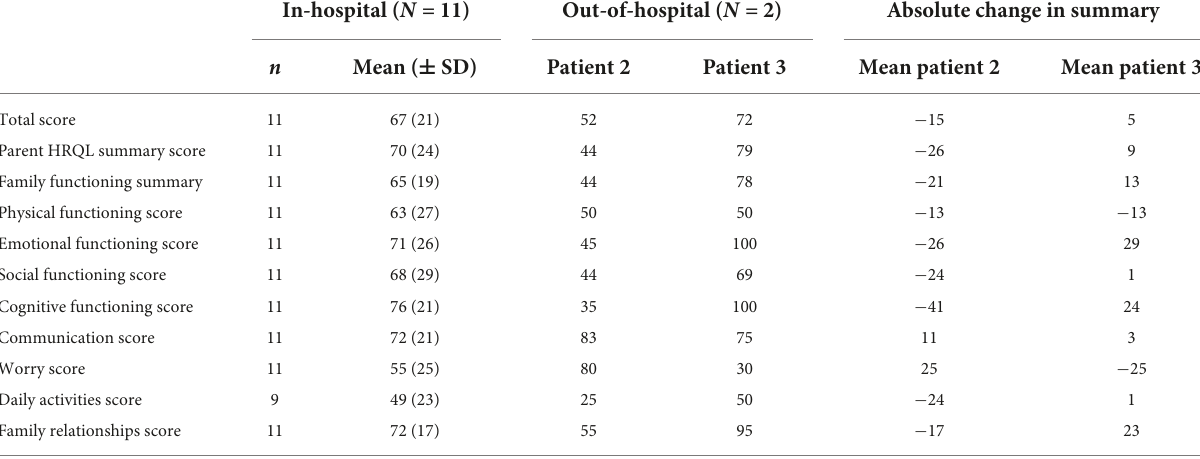
TABLE 2 Quality of life data of 2 of the discharged patients in comparison to 11 in-hospital patients with EXCOR R (cid:13) VAD on EXCOR R (cid:13) active: HRQL, health-related quality of life; N, number of patients in the analysis set; n, number of patients with evaluable data; SD, standard deviation.